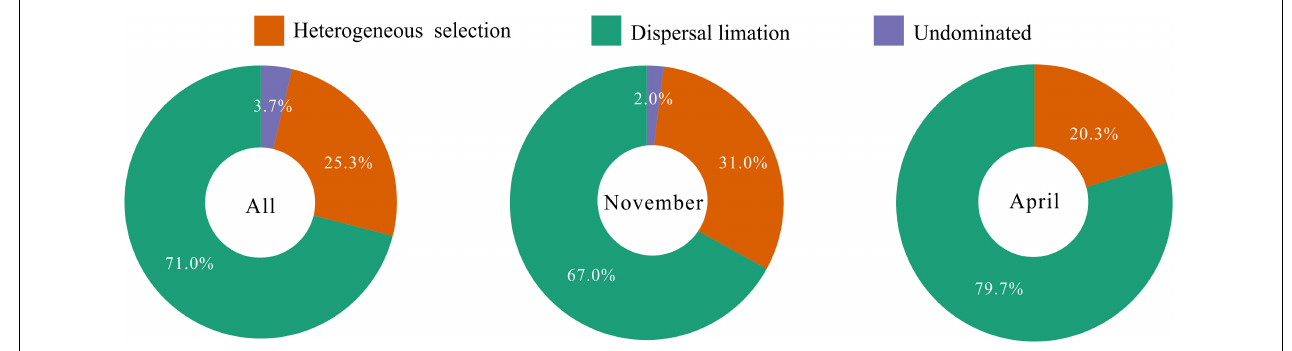
FIGURE 6 | Summary of ecological processes governing the compositional variation of total bacterioplankton communities and the bacterioplankton communities collected in November and April. The percentages are given as the relative contribution of each process to the community variation as indicated by different colors.